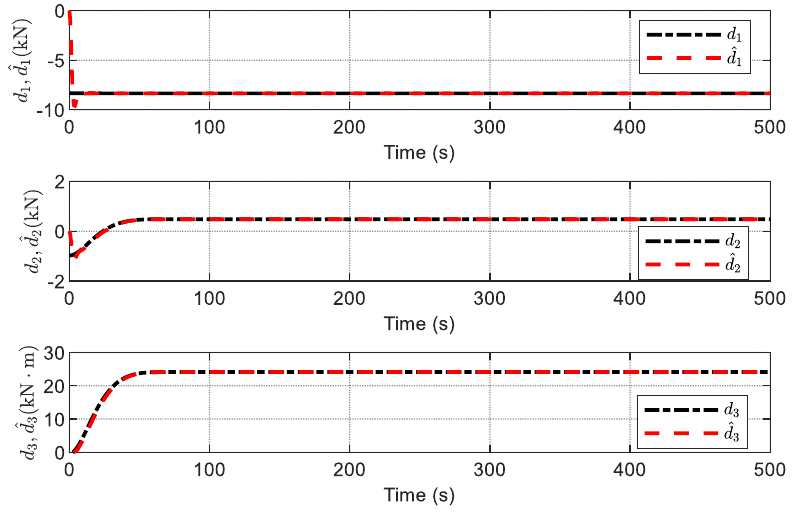
Figure 12. Estimation of disturbances via ADO.